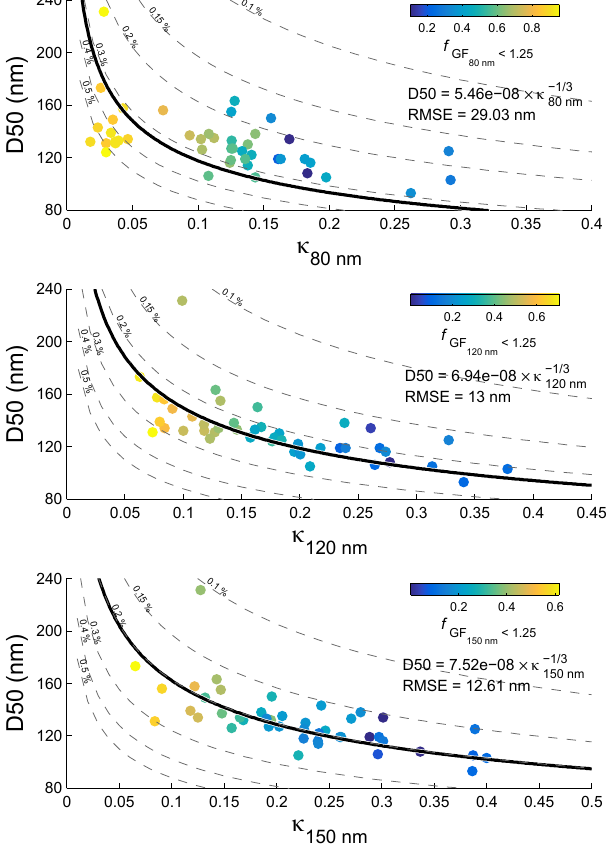
Figure 3. Critical activation diameter (D50) vs. size-averaged hy- groscopicity ( κ ) of 80, 120 and 150nm particles, as well as the power law fits (black lines) to the data. The data points are colored according to number fraction of less hygroscopic particles, and the grey dashed lines represent the numerical solutions of κ -Köhler the- ory in the range of s c =